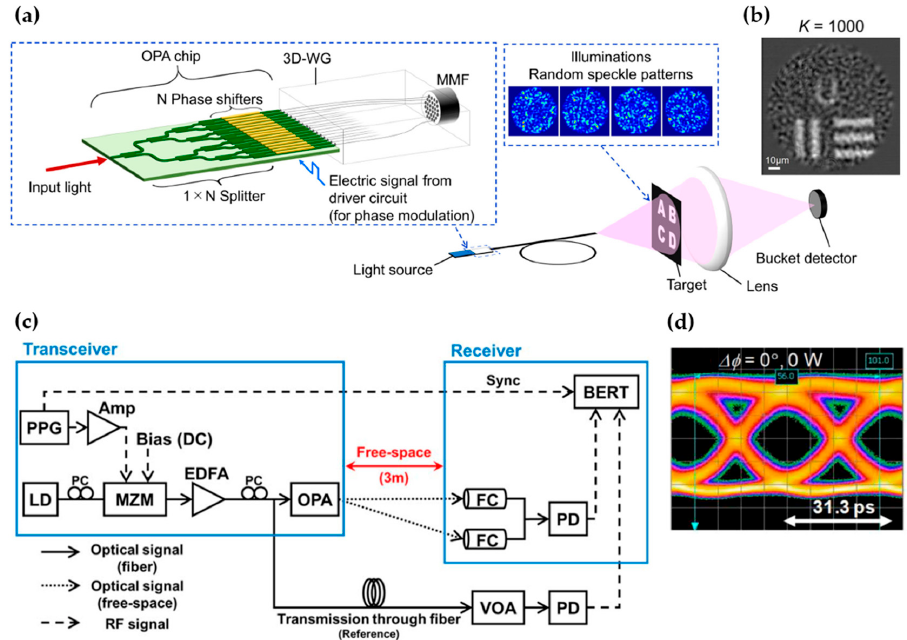
Figure 9. ( a , b ) Schematic and measured image of a single-pixel imaging system. Reprinted, with permission, from [62] © 2022 IEEE. ( c , d ) Schematic and measured eye diagram of an FSO system. Reprinted, with permission, from [11] © 2022 IEEE.